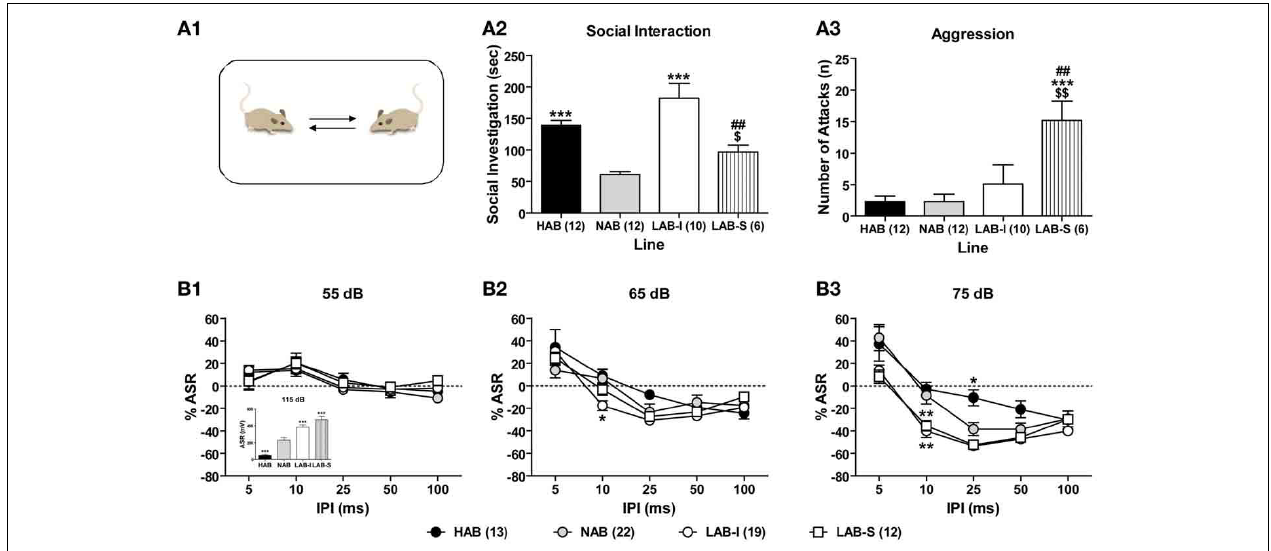
FIGURE 8 | LAB mice showed no deficits in social interaction and PPI. (A1) In a social interaction test, (A2) LAB-I mice spent more time in social investigation than the other three lines; however, (A3) LAB-S mice displayed more aggression compared to the other lines. Mean ± SEM. ∗∗∗ p < 0 . 001 vs . NAB. ## p < 0 . 01 vs . HAB. $$ p < 0 . 01; $ p < 0 . 05 vs . LAB-I (ANOVA followed by post-hoc Newman–Keuls test). Mice of four lines were tested in a PPI test. LAB-I and LAB-S mice displayed higher, and